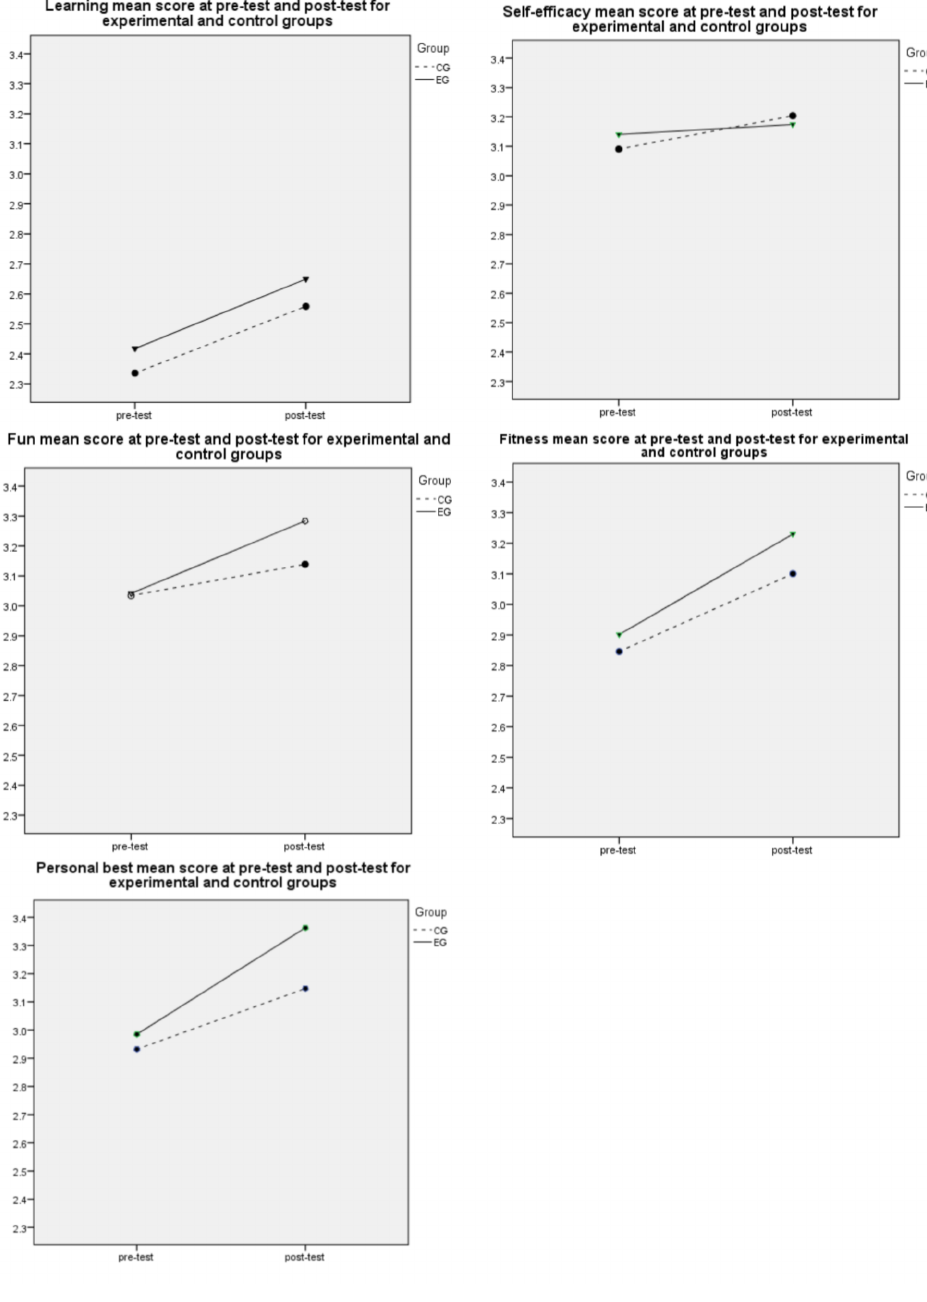
Figure 1. Scale Mean Values of the Experimental and the Control Groups at Pre-test and